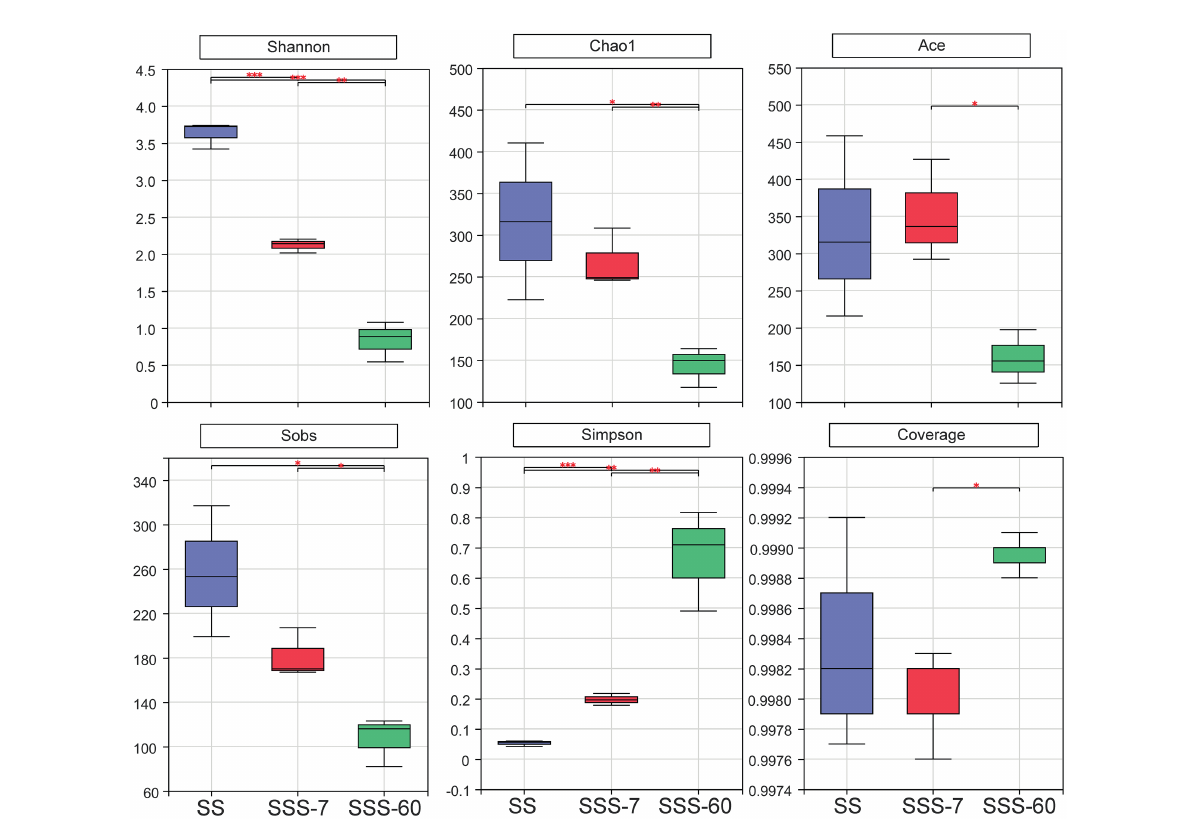
FIGURE 1 Bacterial α -diversities (Shannon, Chao1, Ace, Sobs, Simpsn, Coverage) of SS and SSS. SS, high-moisture sweet sorghum; SSS, SS silage. * p < 0.05; **0.001 < p ≤ 0.01; *** p ≤